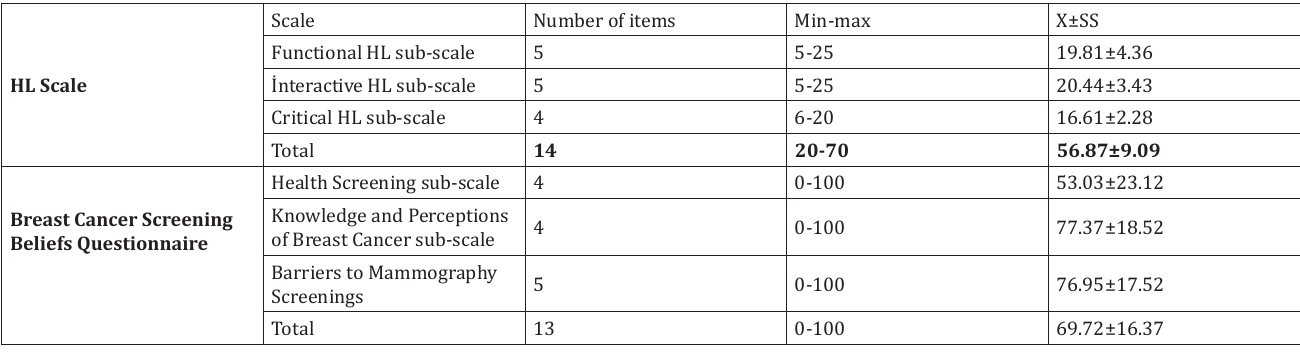
The Health Literacy Scale and Breast Cancer Screening Beliefs Questionnaire Mean Scores